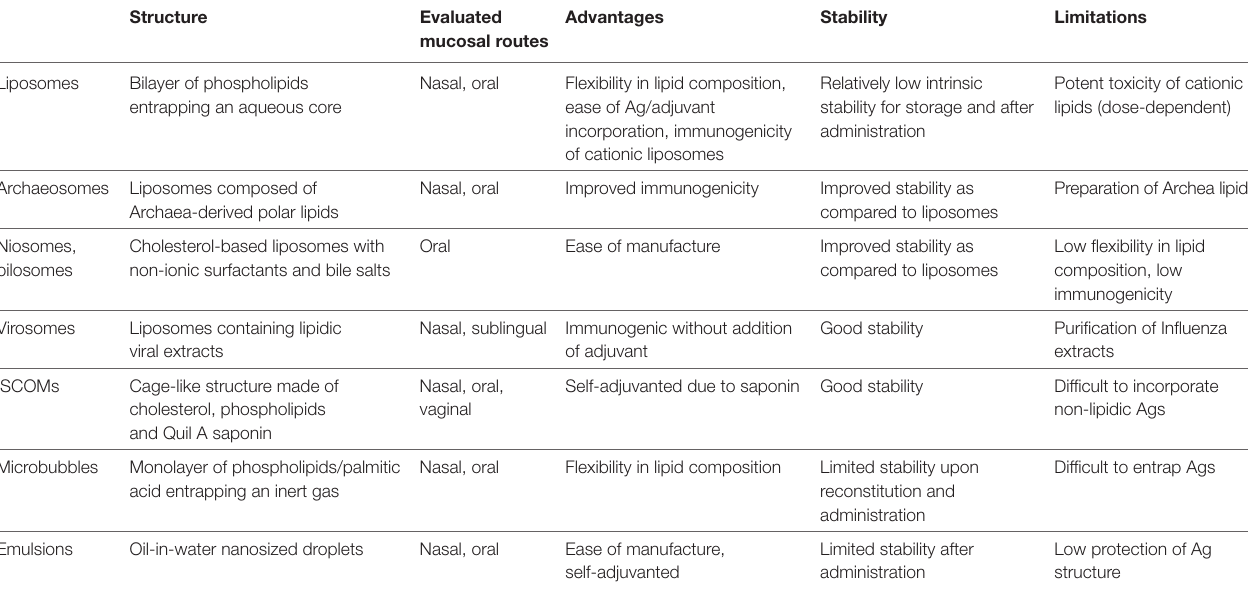
TABLe 1 | Lipid-based formulations evaluated for mucosal vaccination in mouse